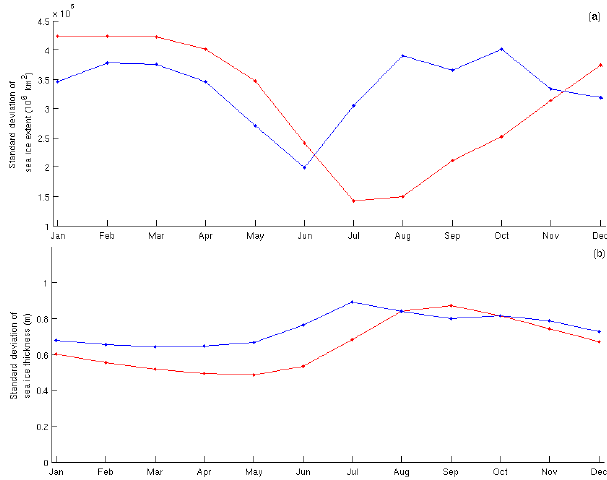
Figure 8. Annual cycle of the standard deviation of (a) sea ice ex- tent and (b) sea ice thickness for the PlioMIP Experiment 2 ensem- ble. Red lines represent the pre-industrial annual cycle; blue lines represent the mid-Pliocene annual cycle.